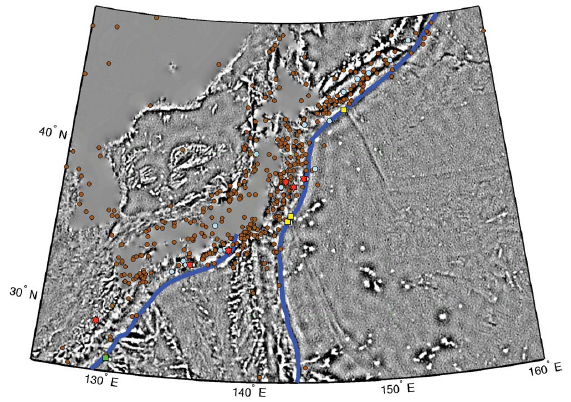
Fig. B2. Tectonic setting and key data for the Japan region. See Fig. B1 for legend. Fig. B3. Tectonic setting and key data for the Central American region. See Fig. B1 for